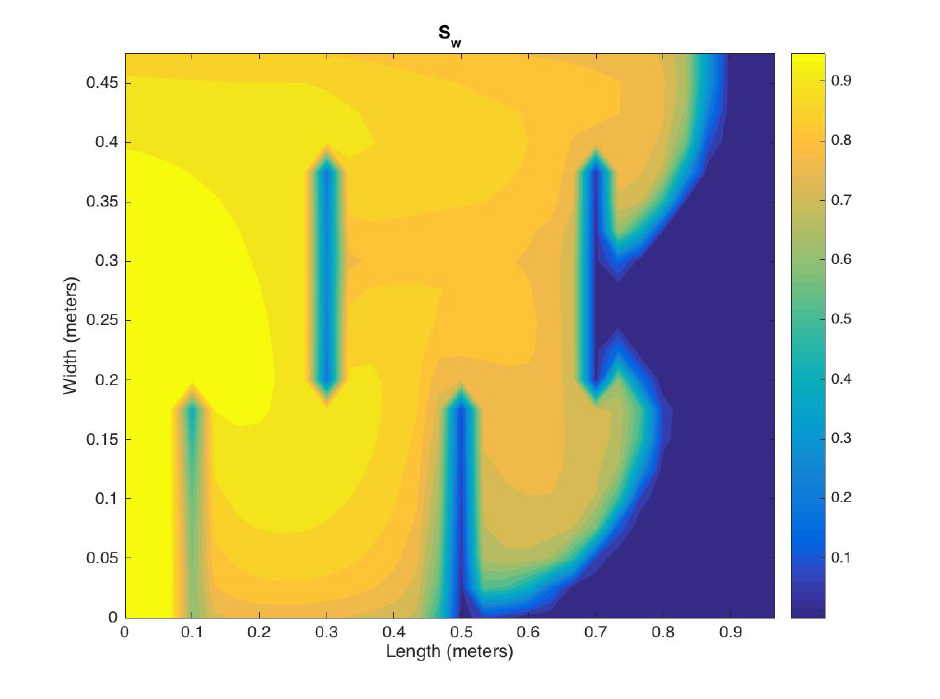
Figure 3. Distribution of saturation on regular permeability map.